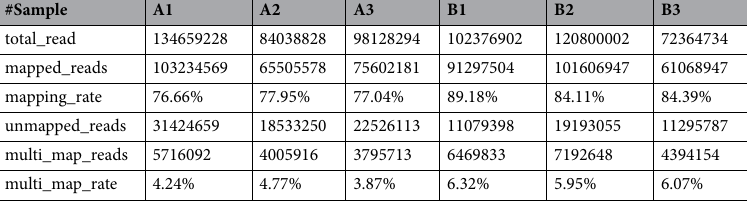
Table 2. Categorization and abundance of tags of PVY-infected and mock-inoculated tobacco RNA libraries.